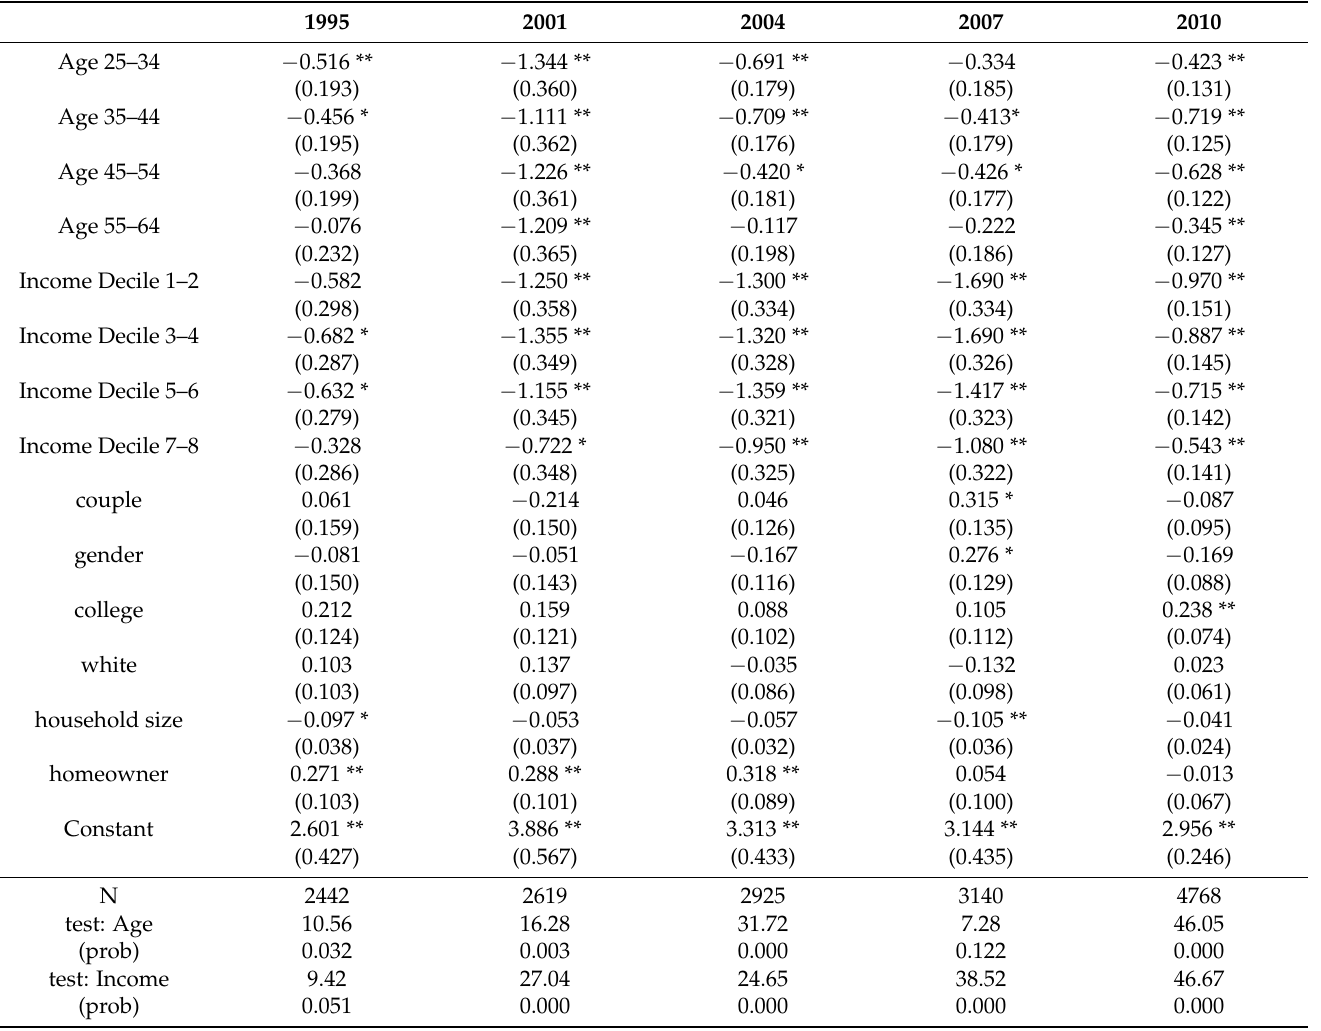
Table 3. Probability of Non-Default Among All